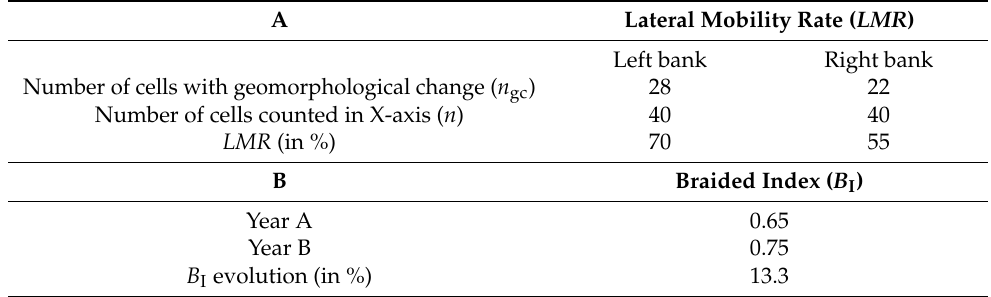
Table 2. Application of the LMR indicator ( A ) and the braiding index ( B ) from the theoretical study case. A Lateral Mobility Rate ( LMR ) Left bank Right bank Number of cells with geomorphological change ( n gc ) 28 22 Number of cells counted in X-axis ( n ) 40 40 LMR (in %) 70 55 B Braided Index ( B I ) Year A 0.65 Year B